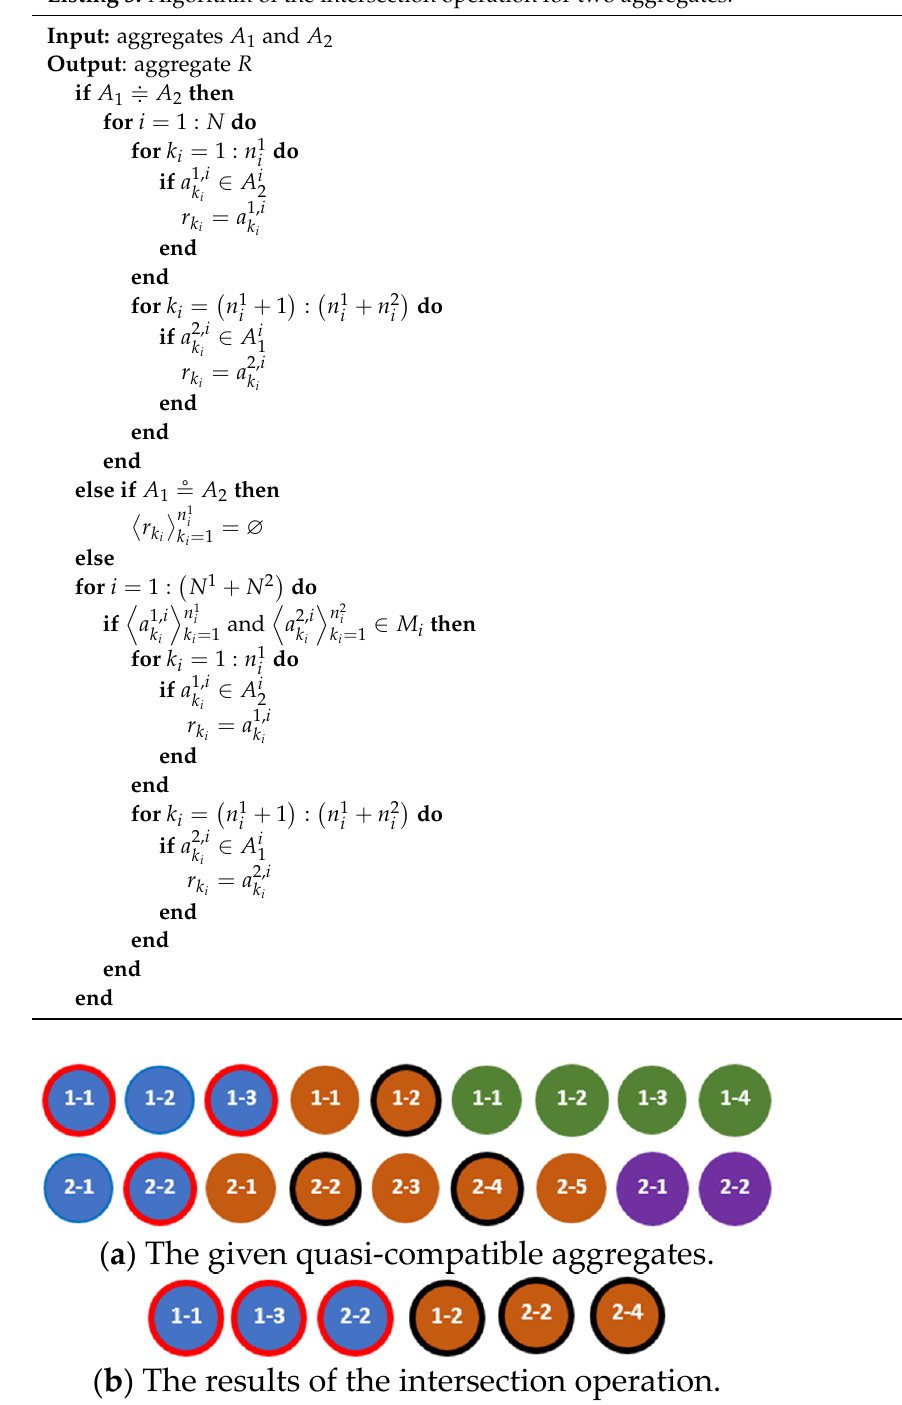
( b ) The results of the intersection operation. Figure 7. An example of applying the intersection operation to two quasi-compatible aggregates. The exclusive intersection of the aggregates A 1 and A 2 is the aggregate R ¬ , which contains only components of the A 1 aggregate that are common in these aggregates and are ordered according to the rule defined in [18]. This rule can be presented as the algorithm for finding a result of the exclusive intersection of two aggregates as shown in Listing